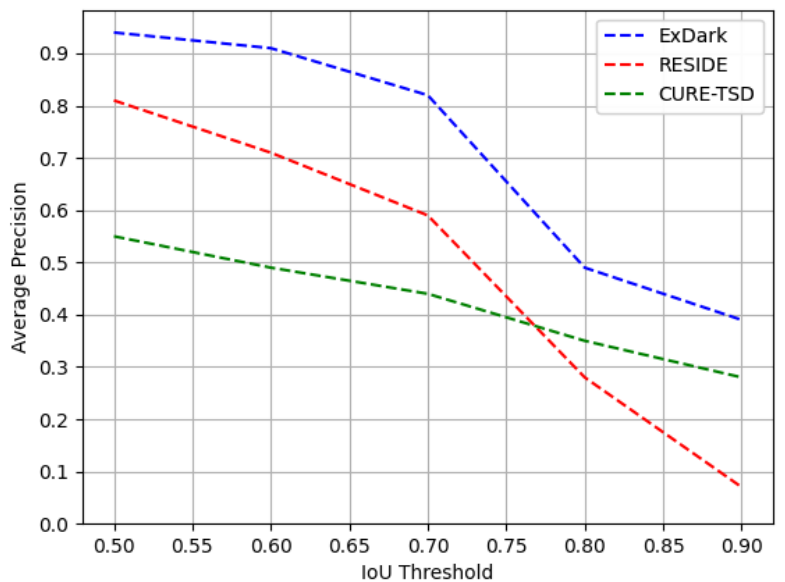
Figure 10. Performance analysis of the proposed module on increasing IoU thresholds from 0.5 to 0.9 on all three employed datasets.